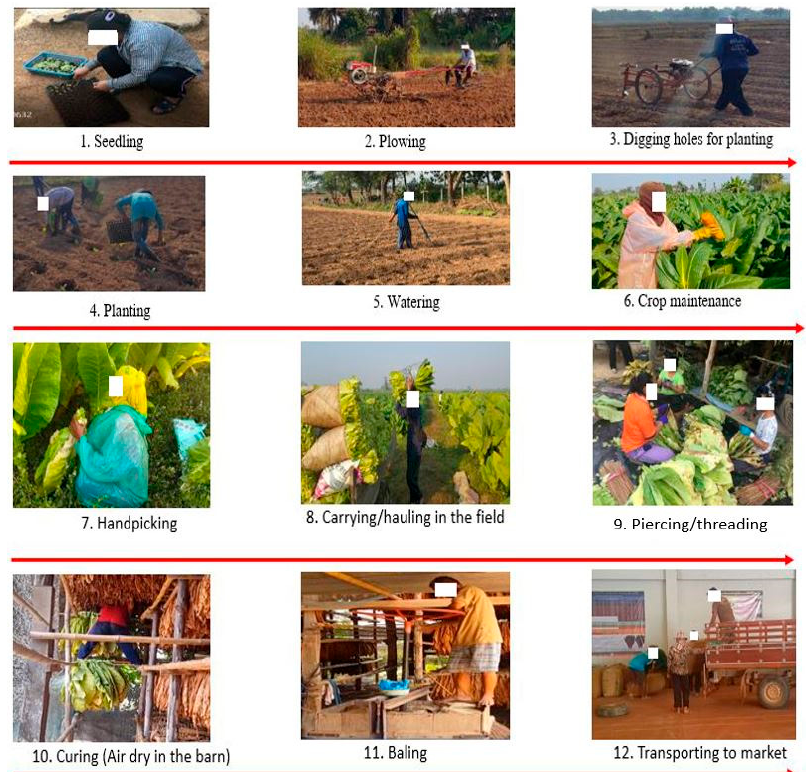
Figure 1. Burley tobacco production: steps 1–6 for the planting season and steps 7–12 for the harvesting period .